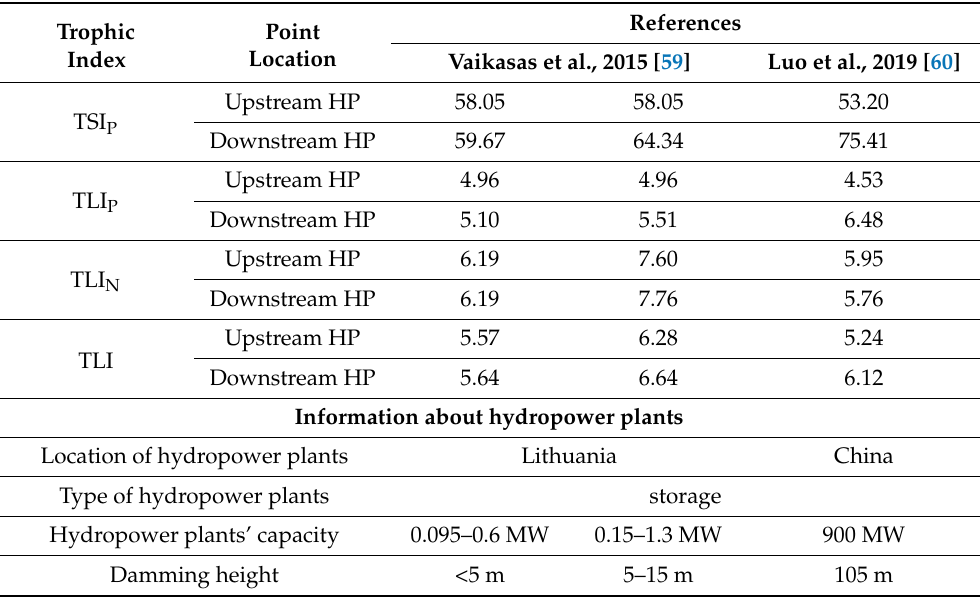
Table 15. Calculated results of trophic indices for other hydropower plants